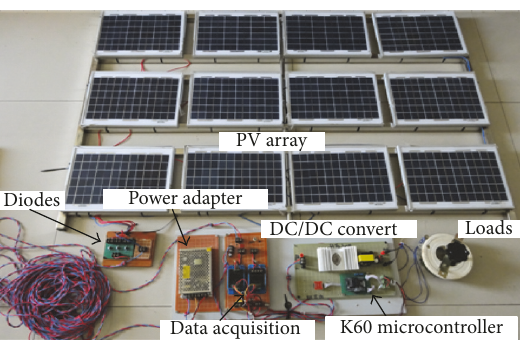
shown in Figure 6.